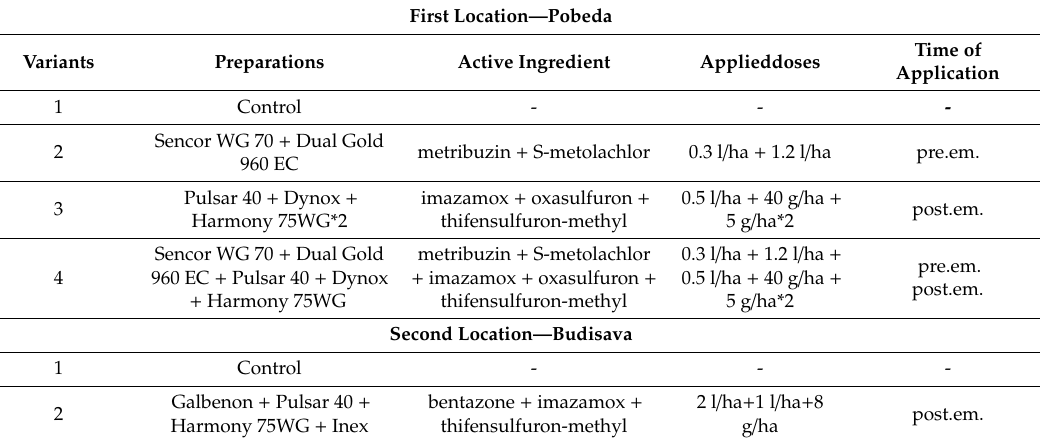
Table 1. Tested herbicides. First